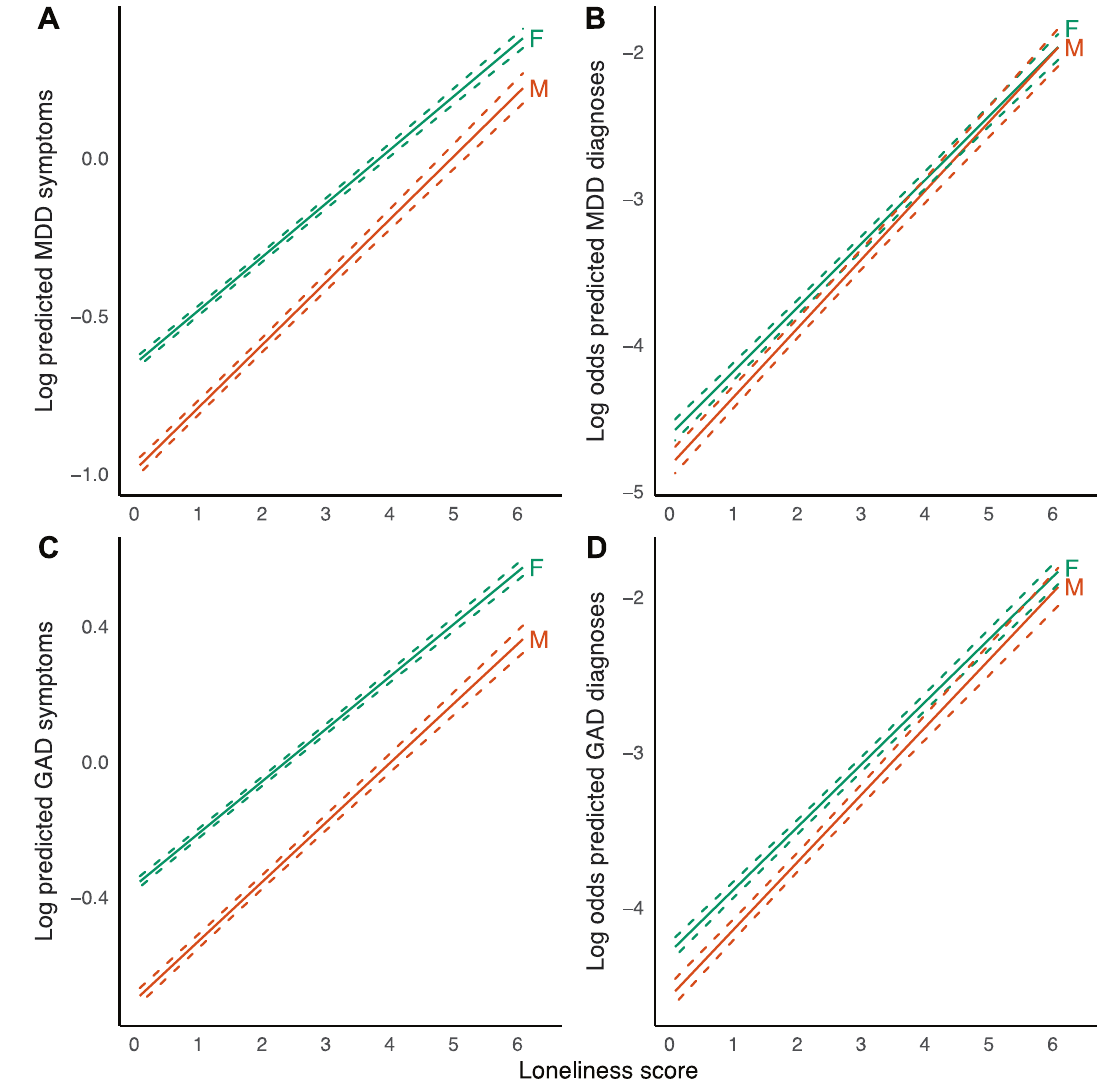
Figure 2. Marginal effect plots of associations between loneliness and MDD and GAD outcomes across sex. Displayed are log predicted counts of MDD symptoms ( A ) and log odds of MDD diagnosis ( B ), as well as log predicted counts of GAD symptoms ( C ) and log odds of GAD ( D ), across different loneliness scores, for men (M) and women (F) (plotted estimates are derived from Tables 2 and 3, main models). Dashed lines represent 95% confidence intervals of model-predicted